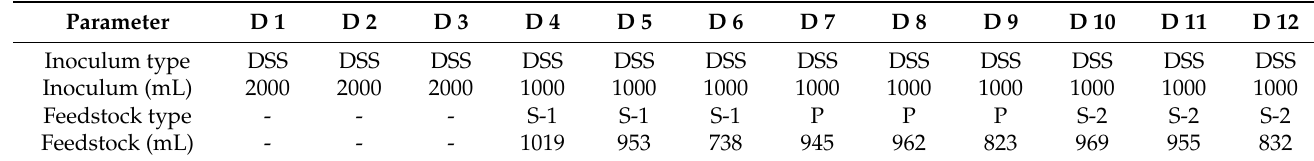
Table 1. Experimental set-up of the anaerobic digestion experiments for each digester (D) presenting the mixtures containing digested sewage sludge (DSS) and different types of press waters (spruce: S, poplar: